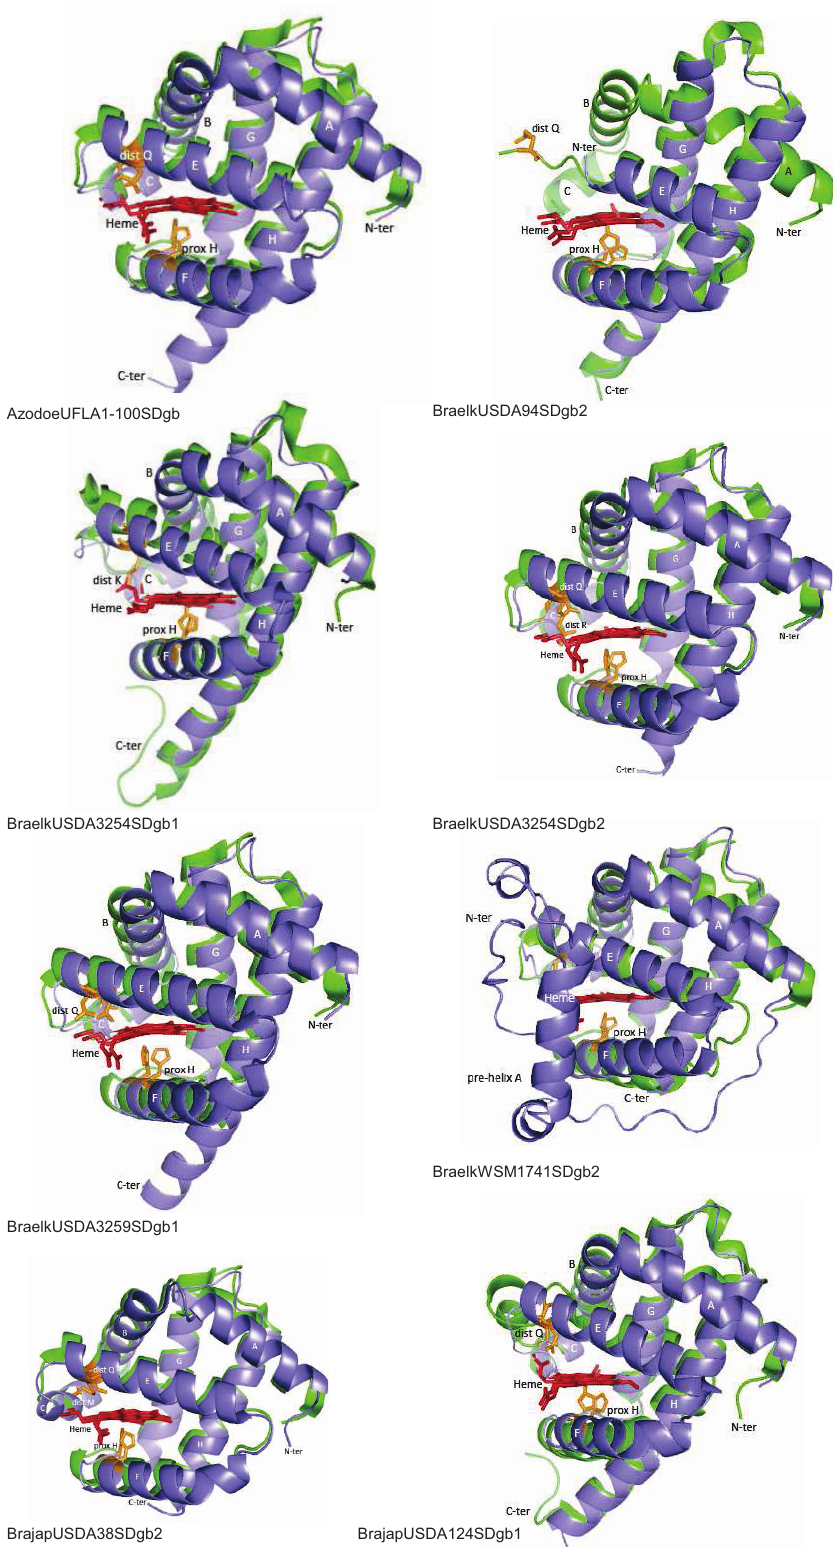
Figure 4. Predicted structure of selected rhizobial SDgbs (blue) overlapped to structural homologues (green). Structural homologues are indicated in Dataset 3. Distal and proximal amino acids to the heme Fe are shown in brown. Heme is shown in red. Helices are indicated with letters A to H. All structures are displayed in the same